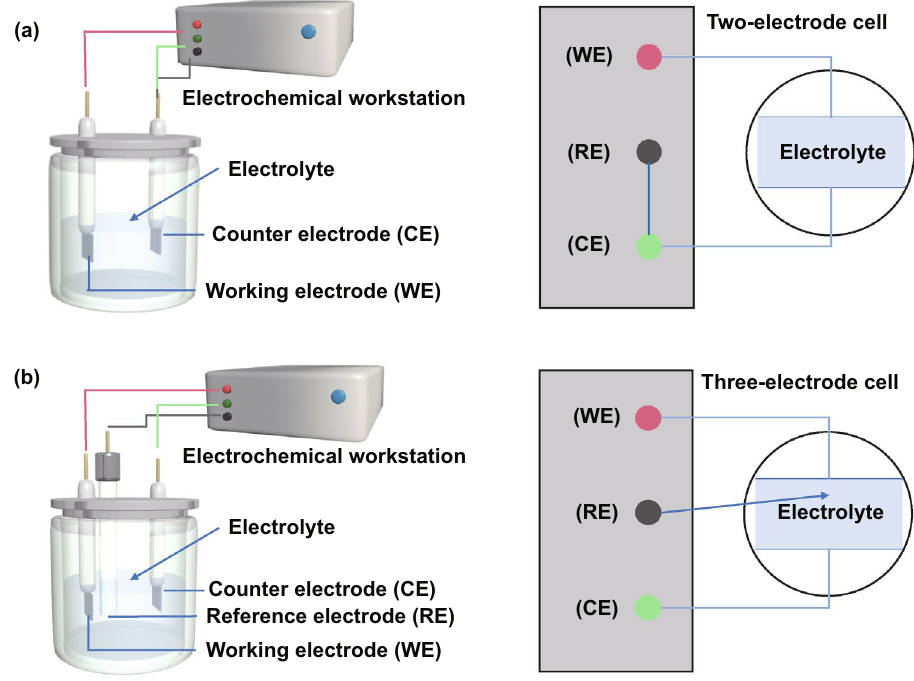
Fig. 1 Schemes illustrating the experimental setups of a two‑electrode and b three‑electrode electrolytic cells for electrochemical